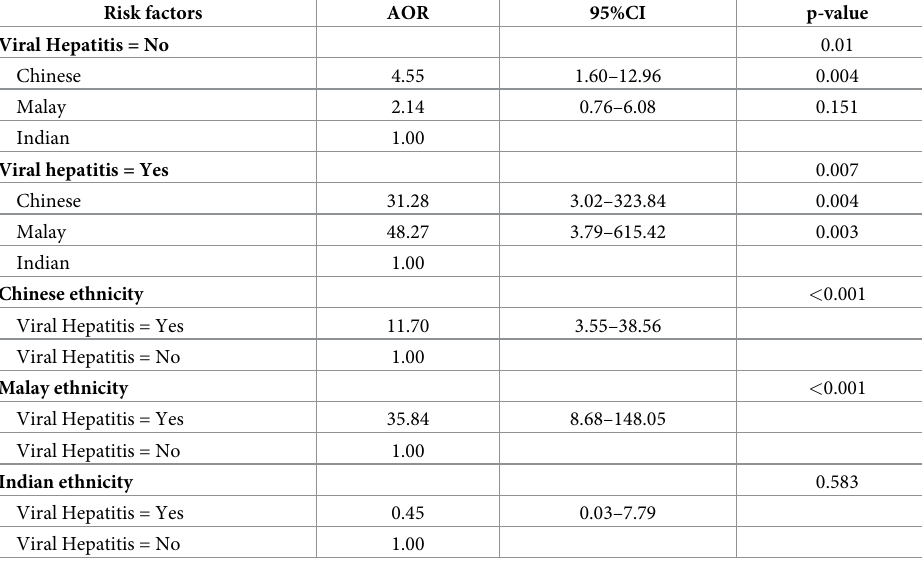
Table 3. Adjusted odds ratio for the interaction between race and viral